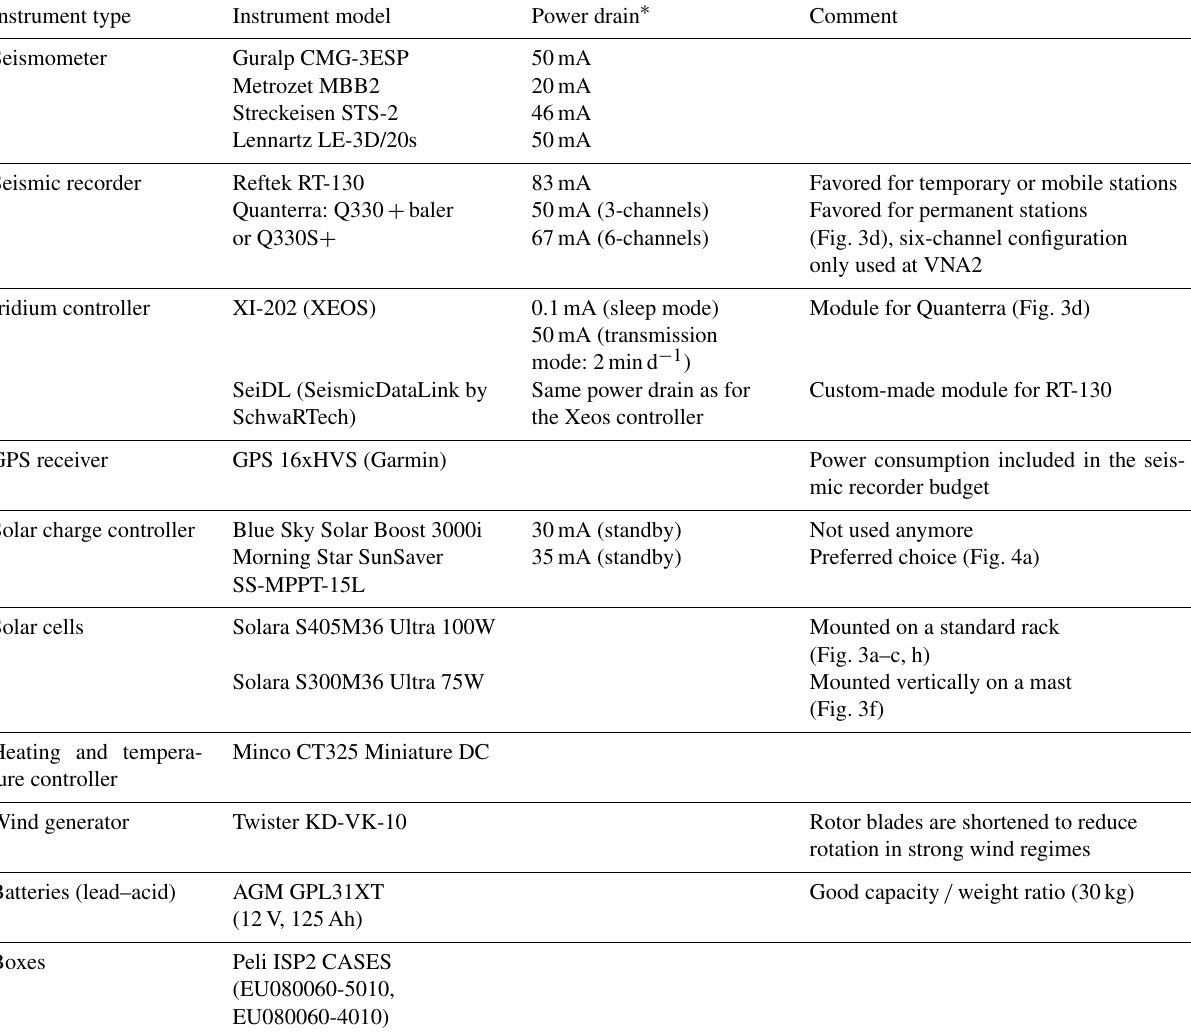
Table 1. Specifications of instruments deployed with AWI’s seismic stations. The power drain values represent average